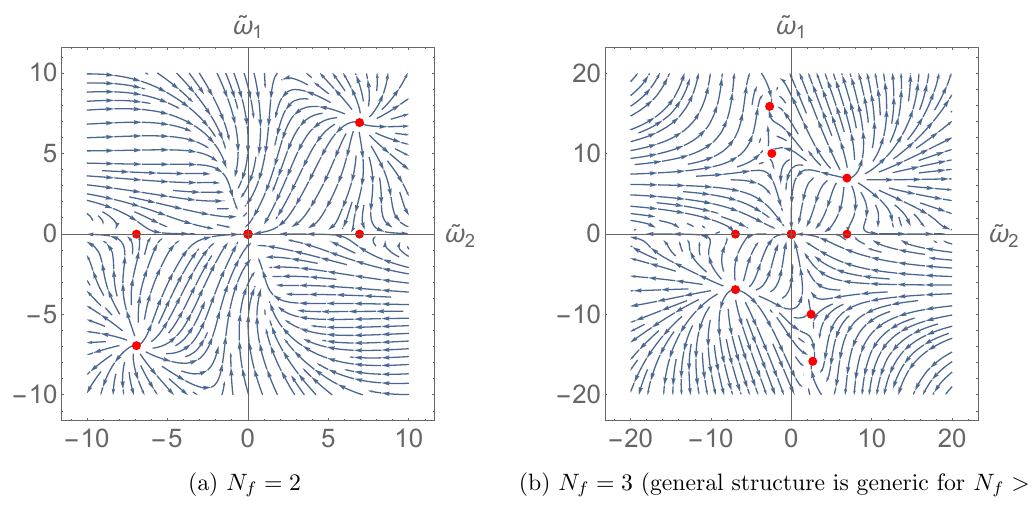
Figure 17. Fixed points in terms of ~ !